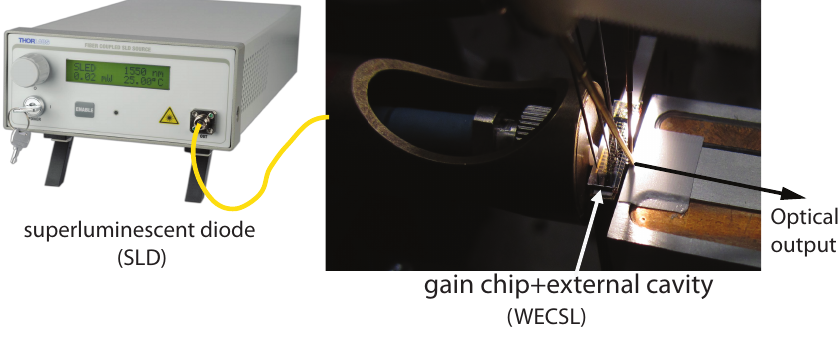
Figure 1. Photograph of the WECSL